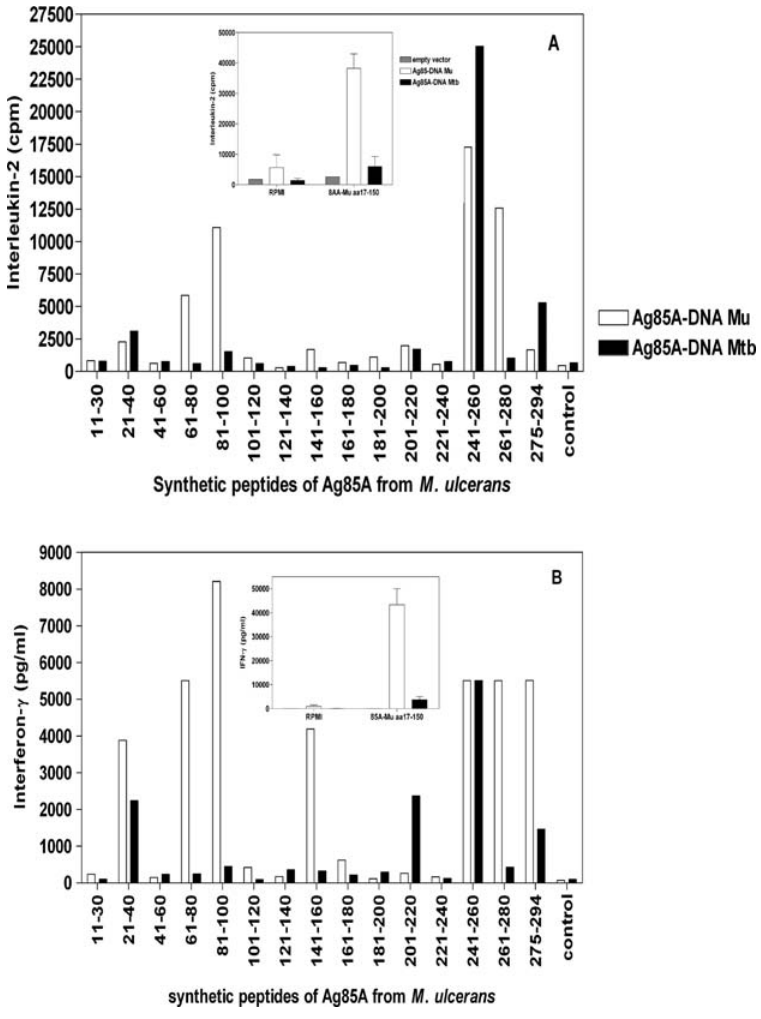
Figure 3. Spleen cell IL-2 (A) and IFN- c (B) responses to whole Ag85A- M.ulcerans and its synthetic peptides, as tested on a pool of six B6 mice vaccinated 3 times at three weeks interval with Ag85A-DNA M.ulcerans (white bars) or Ag85A-DNA M.tuberculosis (black bars). Graph in insert represents the cytokine production in response to partial Ag85A M. ulcerans aa 17–150. Unstimulated cells (grey bars). Data of insert represent mean 6 SD values of 3 mice tested